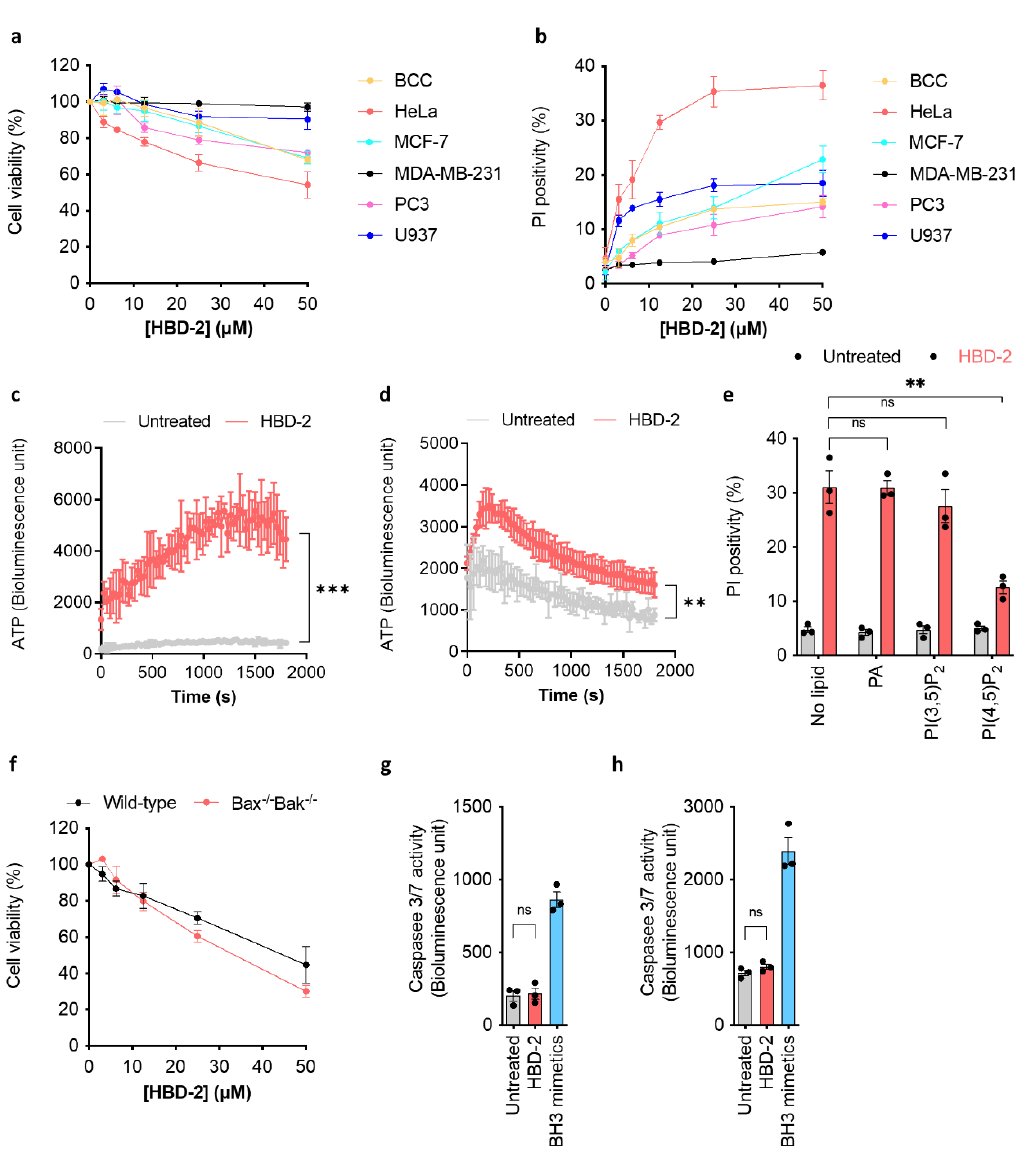
Figure 1. HBD-2 induces tumour cell death in a non-apoptotic manner. ( a ) Dose-dependent reduc- tion in cell viability of different tumour cell lines (BCC, HeLa, MCF-7, MDA-MB-231, PC3 and U937) determined by tetrazolium-based assay. Data normalised against untreated control, which was arbitrarily assigned 100% viability. ( b ) Flow cytometry-based PI uptake assay on tumour- igenic BCC, HeLa, MCF-7, MDA-MB-231, PC3 and U937 cells. The level of permeabilisation was expressed as PI positivity. ATP bioluminescence assay of HeLa ( c ) and U937 ( d ) cells treated with HBD-2 (50 μ M) titrations. The level of ATP released was detected as bioluminescence emission signal intensity. Data represent mean ± SEM of three independent experiments. ** p < 0.01, *** p < 0.001; Two-way ANOVA. ( e ) Flow cytometry-based PI uptake assay on HBD-2 or PBS pre-incu- bated with PA, PI(3,5)P 2 or PI(4,5)P 2 lipids on U937 cells. ** p < 0.01, ns: not significant; unpaired t - test. ( f ) Dose-dependent reduction in cell viability of MEF wild-type and MEF Bax/Bak double knockout cells. Caspase-Glo 3/7 activity assay on U937 ( g ) and HeLa ( h ) cells treated with HBD-2 or BH3 mimetics over 30 min. Data represent the mean ± SEM of three independent experiments. ns: not significant; unpaired t